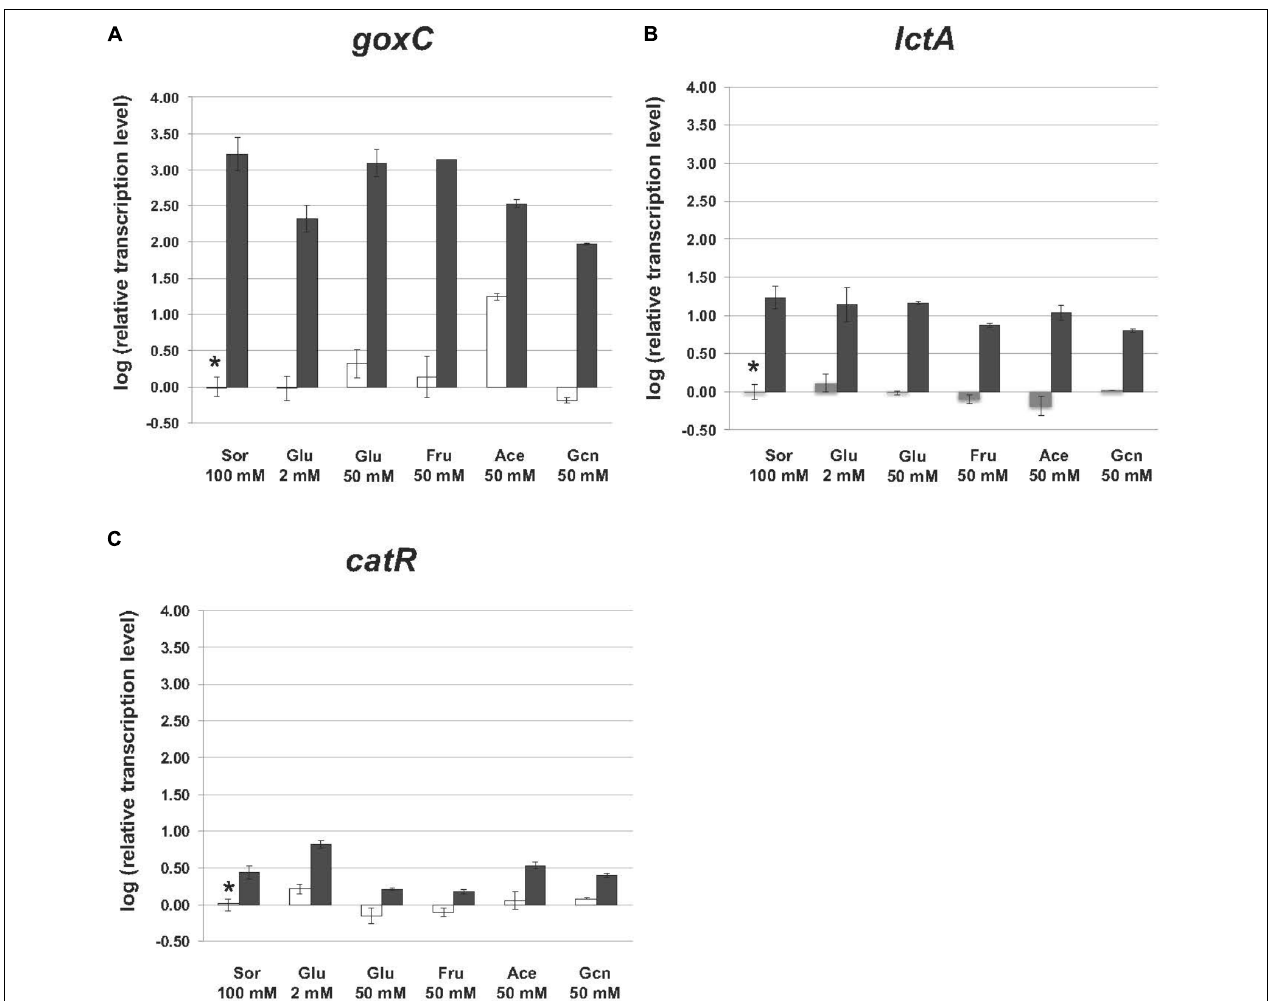
FIGURE 6 | Expression of the glucose oxidase and lactonase, encoding genes of A. niger strain N402 and (cid:49) trxR -1A in various carbon sources. Samples were taken 4 h after mycelium transfer to the medium with different carbon sources including glucose (Glu), fructose (Fru), acetate (Ace) gluconate (Gcn), and sorbitol (Sor). Expression analysis was performed by RT-qPCR with the primers specific for goxC (A) , lctA (B) , and catR (C) gene. White bars indicate expression levels obtained in strain N402, black bars in (cid:49) trxR -1A and gray bars in (cid:49) trxR -3A. Normalization of the expression data was done using the histone 4-like gene transcript. Results were calculated as relative transcript ratio in logarithmic scale (log10) with means of two biological replicates. Asterisks represents transcript level of the reference